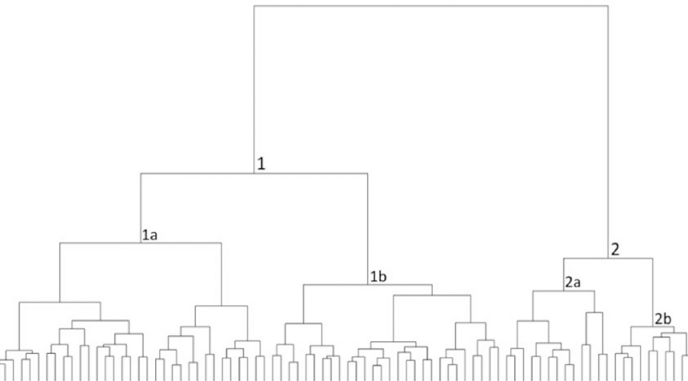
Fig 8. Cluster tree for 85 Iron Age II OSJ and Rosetta jars. The lines at the base represent one item in the assemblage, and each branch represents a segregated morphological group (type variation) based on similarity.